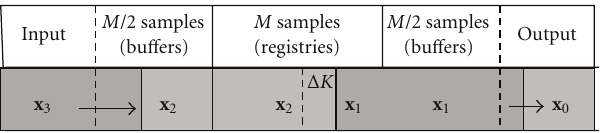
Figure 2: Received signal samples in registers.